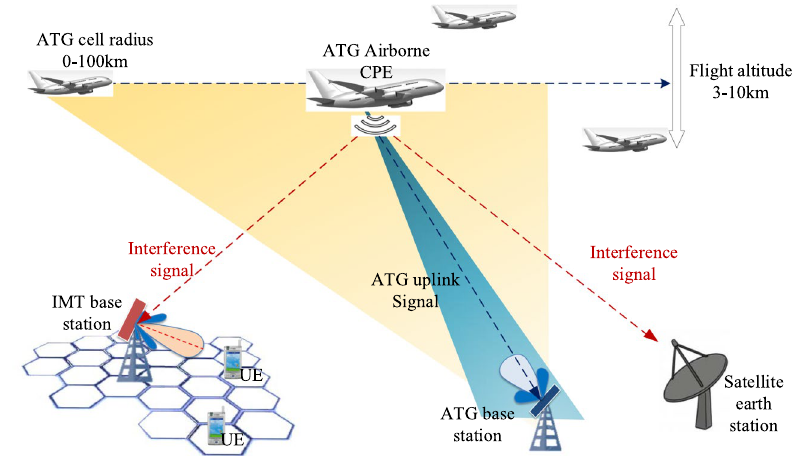
Fig. 1 Schematic diagram of airborne CPE uplink interference in ATG system